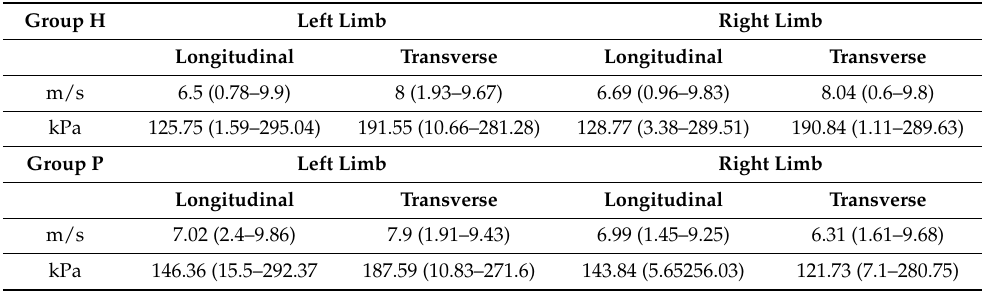
Table 3. Velocity (m/s) and Young’s modulus (kPa) in Group S and Group P in left and right limb. Values are expressed as median and range. Statistical significance was set at p < 0.05.